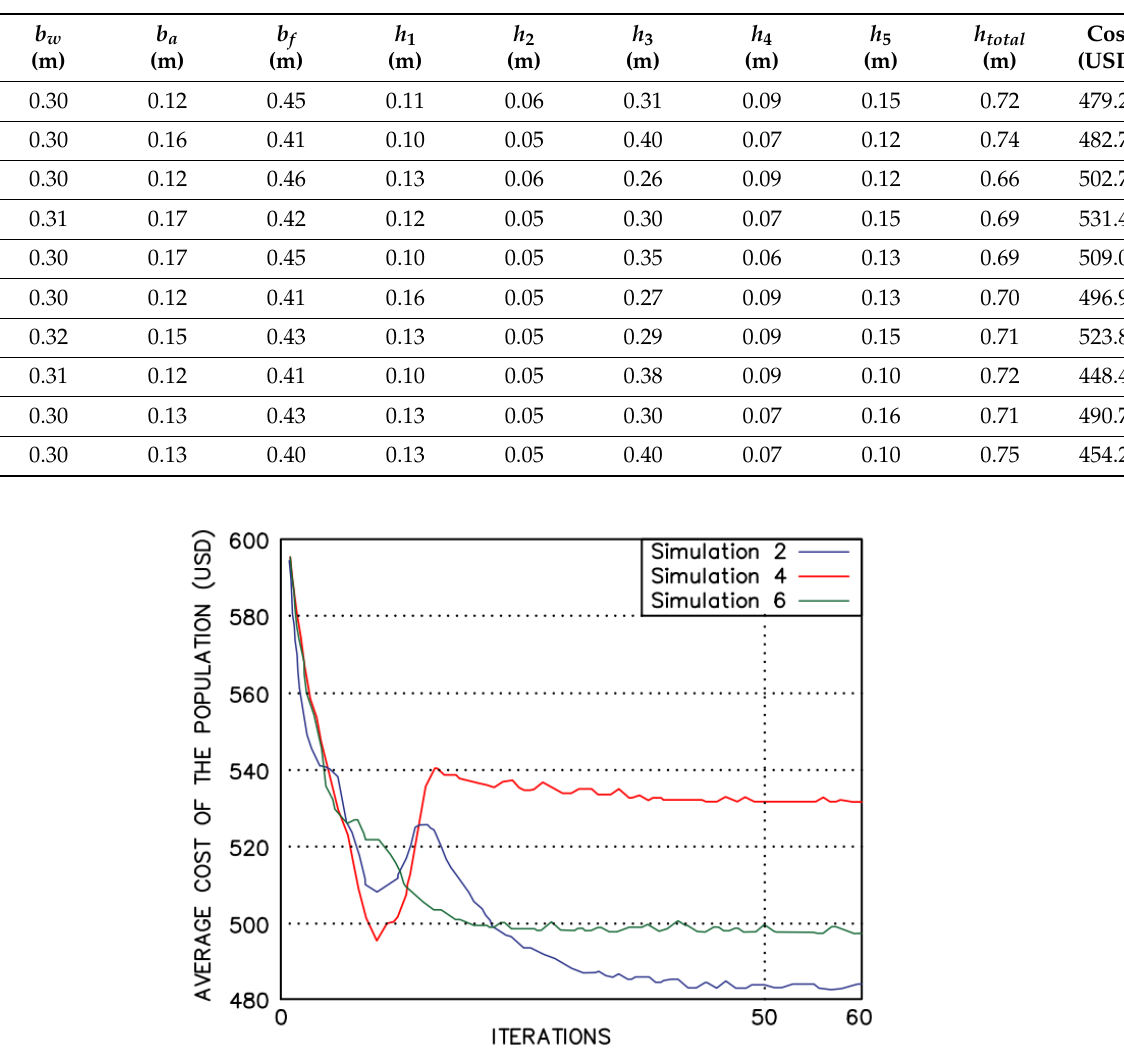
Table 1. Summary of solutions (150 individuals, 60 iterations, 1% mutation rate η = 4).